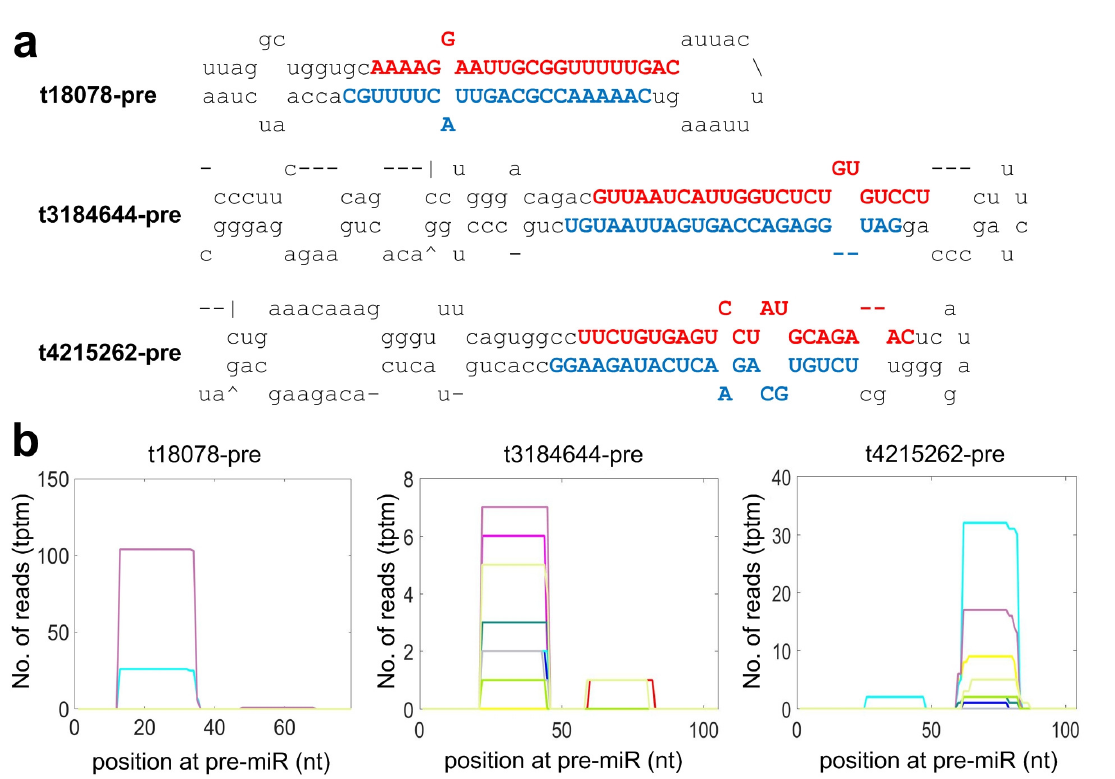
Figure 2. Three of the species specific miRNAs of Macaca mulatta identified in this study. ( a ) The secondary structure of precursors of identified miRNAs. The blue and red regions in the precursors represent the mature miRNAs that were sequenced in the 12 self-generated sRNA-seq profiles. ( b ) The distributions of sequencing reads on the pre-miRNAs in ( a